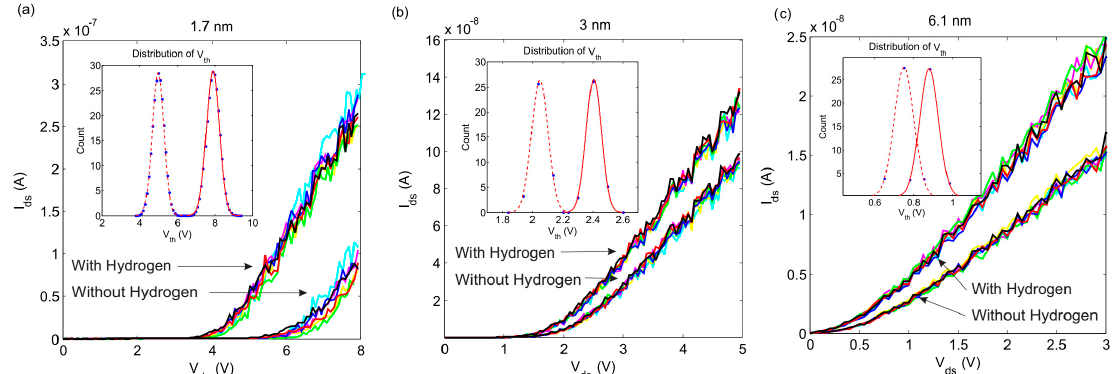
Figure 5. Effect of the Gaussian distribution on the threshold voltage for 10 × 10 arrays of ( a ) 1., ( b ) 3, and ( c ) 6.1 nm Pd nano-islands at room temperature. (Inset images show the distribution of the calculated threshold voltage before (solid) and after (dash) H 2 exposure).